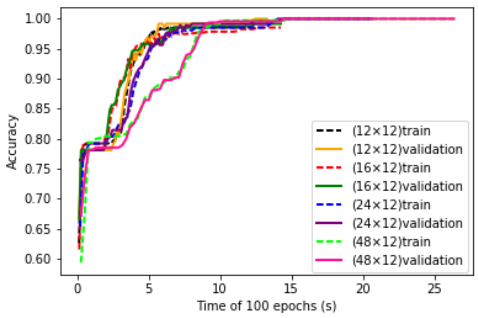
Figure 10. Training and validation curves of LeNet-5 with different sizes of inputs.